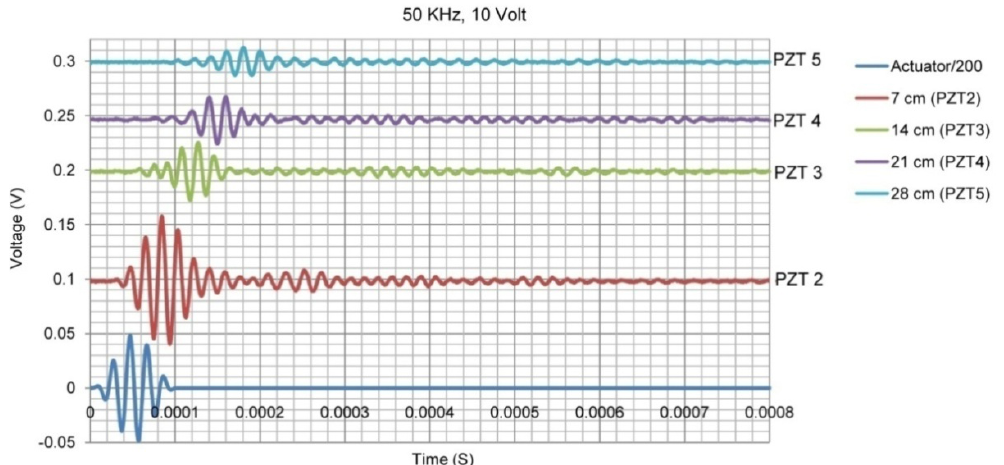
Figure 5. Wave propagation at frequency of 50 kHz with PZT 1 as actuator.